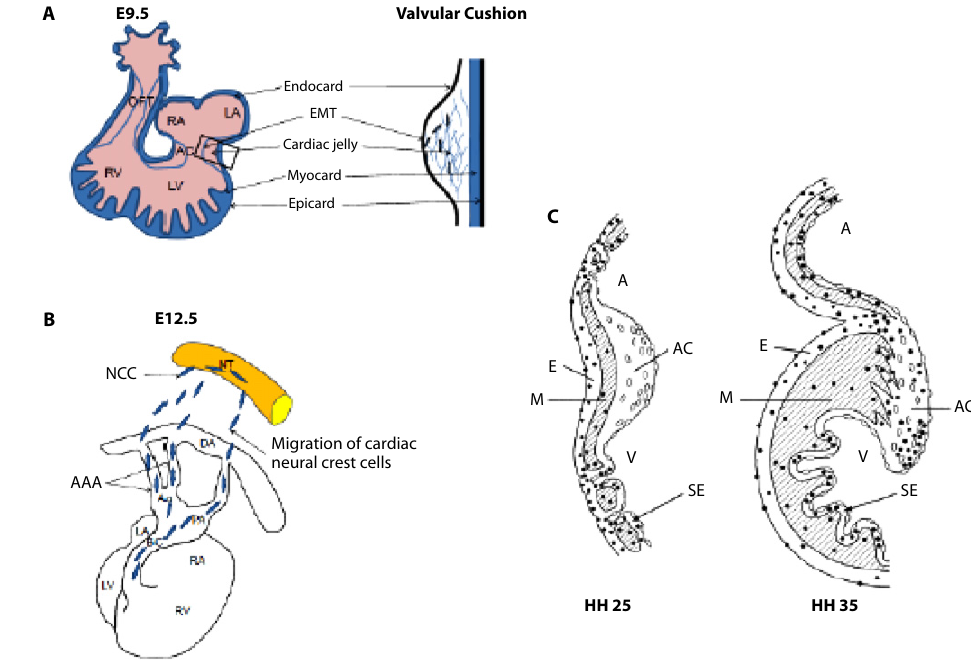
Figure. 1 Important events during valve development. A. Schematic figure of the first signs of valvular cushion formation in mouse embryos at Stage 9.5 dpc. The heart is already looped at this point in the OFT, and the AVC- EMT derived cells migrate in to the cardiac jelly to establish a functioning valve apparatus. Adapted from [58]. B . Migration of the neural crest cells into the outflow tract at stage 12.5 dpc. Neural crest cells play a major role in the formation of the outflow tract and its valvular structures. Disturbances in this migration process results in severe outflow tract anomalies including malfunctioning valves. Adapted from http://php.med.unsw.edu.au. C . Cell immigration into the mesenchyme of the AVC cushions. The Black dots show epicardial cells in the valvular region at stage HH 25 and HH 35 in the chick. Grey dots demarcate the endocardial cells after EMT. Taken from [47]. Abbreviations: NT — neural tube; DA — dorsal aorta; NCC — neural crest cells; RA — right atrium; LA — left atrium; RV — right ventricle; LV — left ventricle; OFT — outflow tract; EMT — epithelial-mesenchymal transition; AV — atrio-ventricular canal; AAA — aortic arches arteries; Ao — aorta; PA — pulmonary artery; A — atrium; V — ventricle; M — myocard; E — epicard; SE —